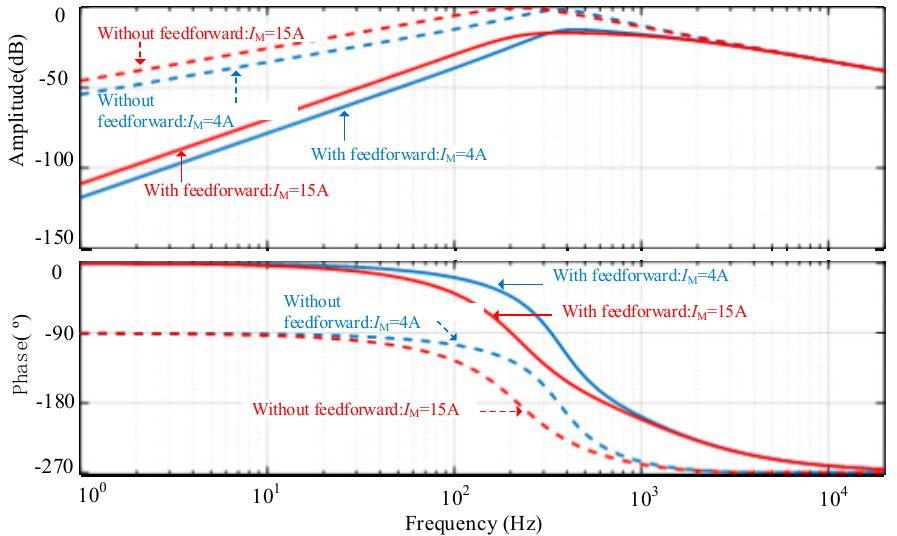
Figure 6. Output impedance of the converter with different loads.